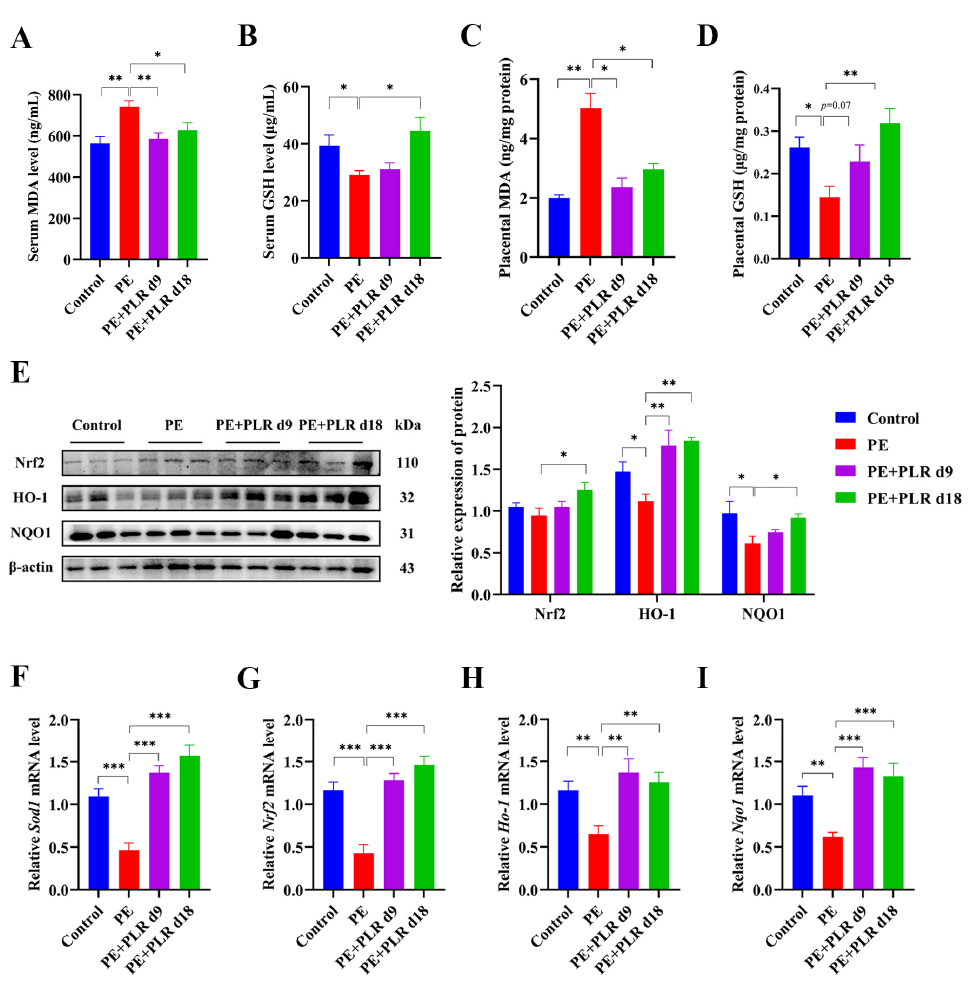
Figure 3. PLR attenuated oxidative stress and upregulated the placental Nrf2/HO-1/NQO1 pathway in PE mice. ( A – D ) ELISA was used to analyze the concentrations of malondialdehyde (MDA)